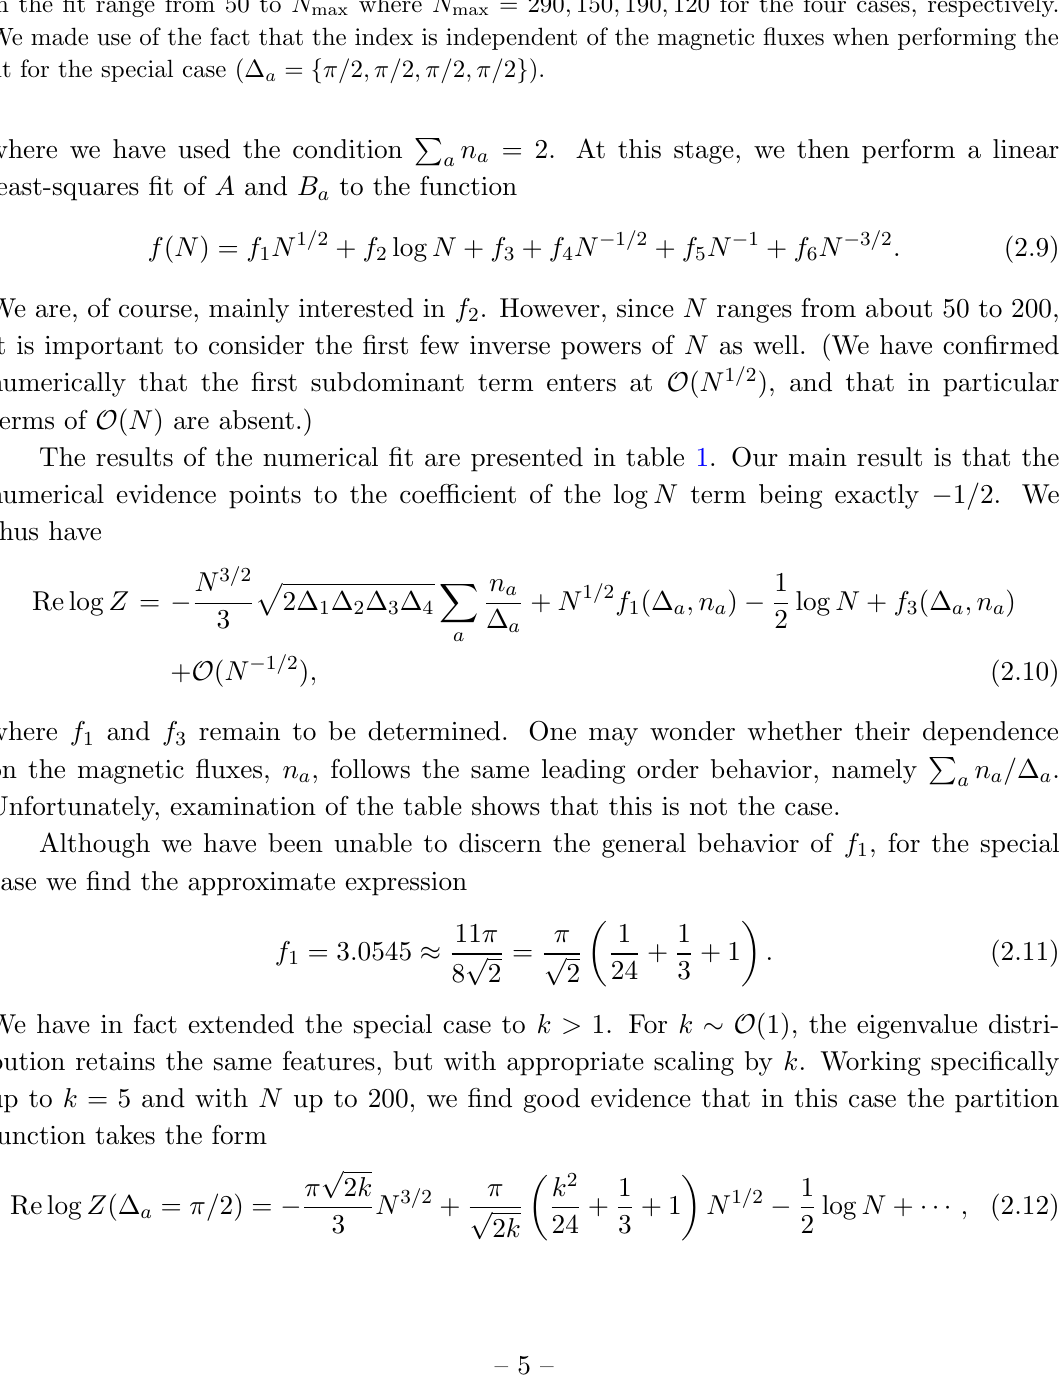
Table 1 . Numerical (cid:12)t for Re log Z = Re log Z 0 + f 1 N 1 = 2 + f 2 log N + f 3 + (cid:1) (cid:1) (cid:1) . The values of N used in the (cid:12)t range from 50 to N max where N max = 290 ; 150 ; 190 ; 120 for the four cases,